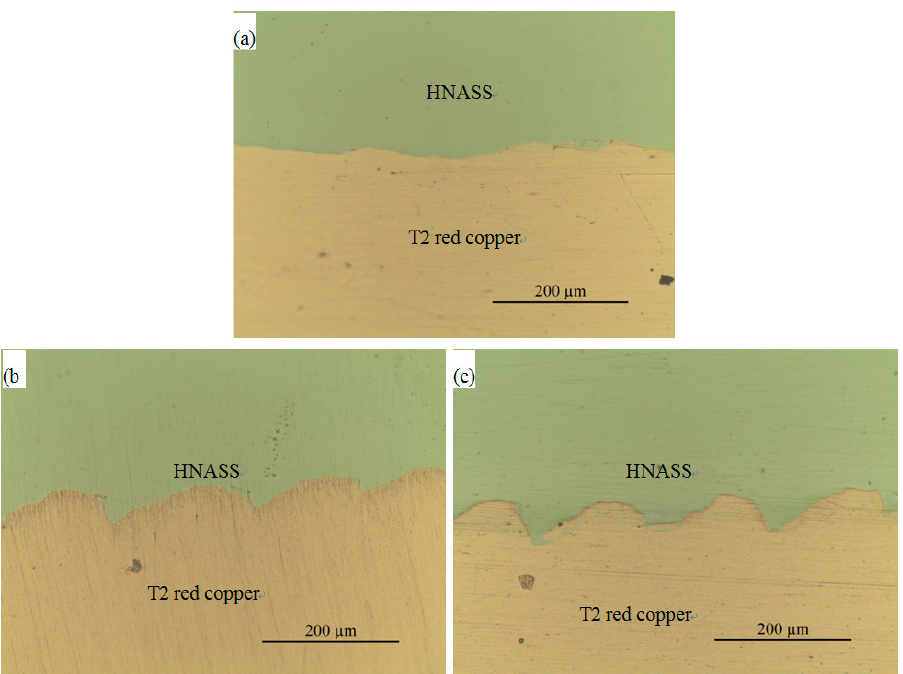
Figure 5. Morphologies of the joint surface for different explosive ratios. ( a ) R =0.9; ( b ) R =1.1; ( c ) R =1.6.